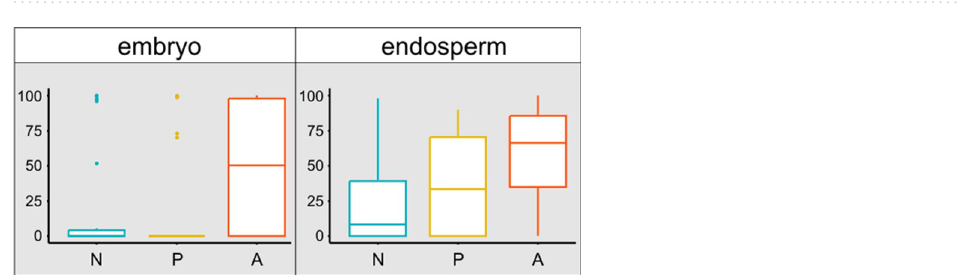
Figure 3. The share of alive, dying (in first and second stage) and dead cells noted in endosperm and embryo of Pulsatilla vernalis seeds, which were not undeveloped: 12 seeds of natural origin (N), 15 seeds from ex situ plantation of lowland Polish origin (P) and 22 of Alpine origin (A); boxplots with median, interquartile (Q1-Q3) range, min–max and outliers were made for the values of percentage share of alive, dying and dead cells in the seed preparation.